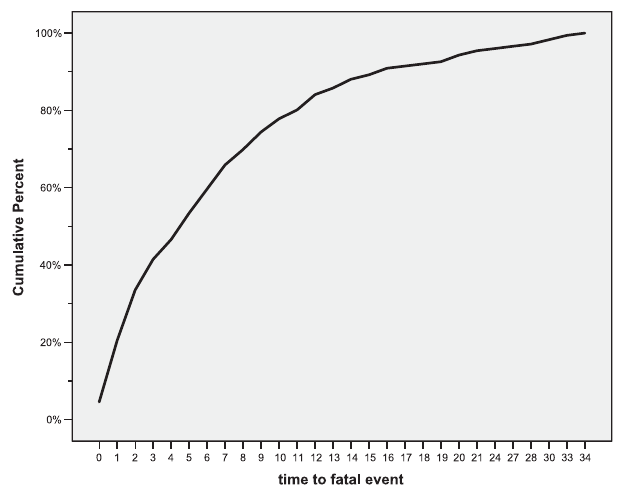
Figure 2. Timing of In-Hospital Death Day 14 represents the percentage of all deaths (176) that occurred in the second week (day 14 to 20), and day 21 represents the percentage of all deaths that occurred on or after 21 d of inpatient treatment.